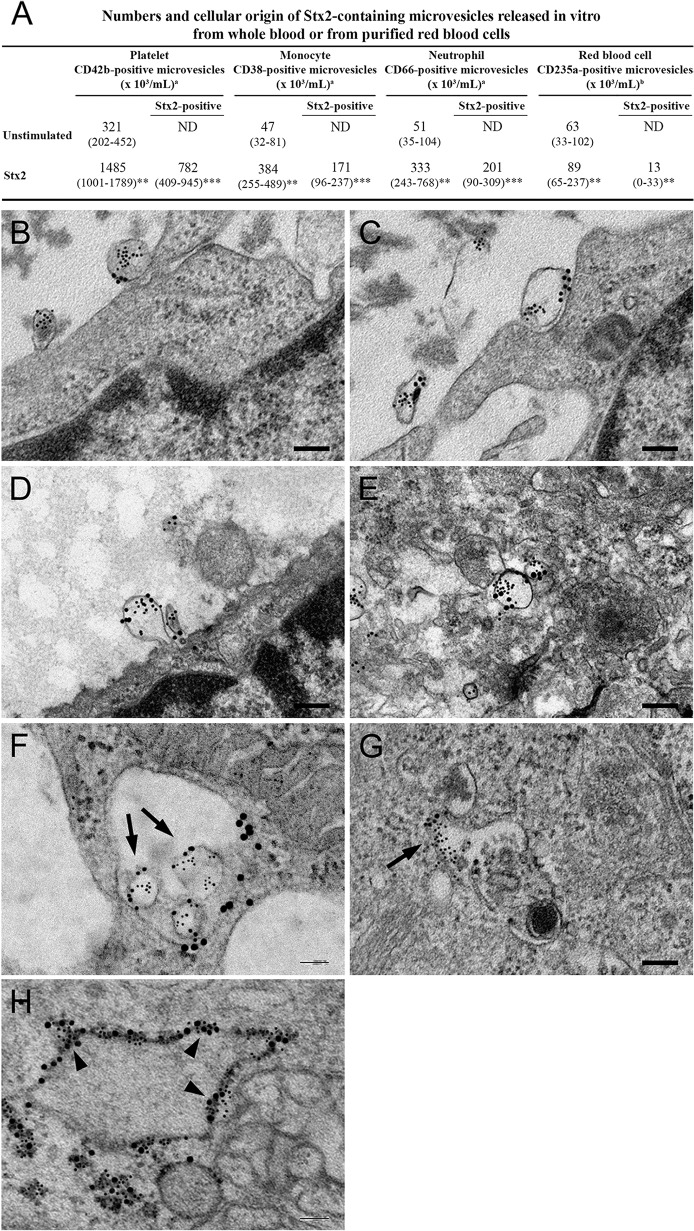
Blood cell-derived microvesicles transfer Stx2 to glomerular endothelial cells in vitro.(A) Data are expressed as median and (range) of microvesicles positive for each membrane specific marker/mL of plasma. a, Microvesicles released from whole blood (n = 6). b, Microvesicles released from purified RBCs (n = 10). *** Denotes P value <0.001, ** P<0.01 and * P<0.05 when comparing microvesicle generation in whole blood stimulated with Stx2 with unstimulated whole blood, or RBCs stimulated with Stx2 with unstimulated RBCs. ND: not detected. (B—H) Conditionally immortalized glomerular endothelial cells (CiGEnC) were incubated with microvesicles isolated from Stx2-stimulated whole blood for 1–24 h. Cells were stained with rabbit anti-Stx2 (5 nm gold particles) and mouse anti-human CD42b or mouse anti-human CD45 to identify platelet- or leukocyte-derived microvesicles, respectively (10 nm gold particles). After 1 h of incubation Stx2-containing platelet- (B, C) and leukocyte- (D) derived microvesicles bound to and appeared to fuse with the cell membrane or were found in the cell cytoplasm (E, platelet microvesicle). At 3 h Stx2-containing microvesicles are demonstrated within early endosomes, see arrows (F, leukocyte microvesicle, anti-early endosome antibody detected with 20 nm gold particles). Endosome membranes were disrupted after 12 h, see arrow (G, leukocyte microvesicle) and Stx2 was bound to ribosomes (arrowheads) in the cytoplasm after 24 h (H, anti-ribosome antibody detected with 20 nm gold particles).